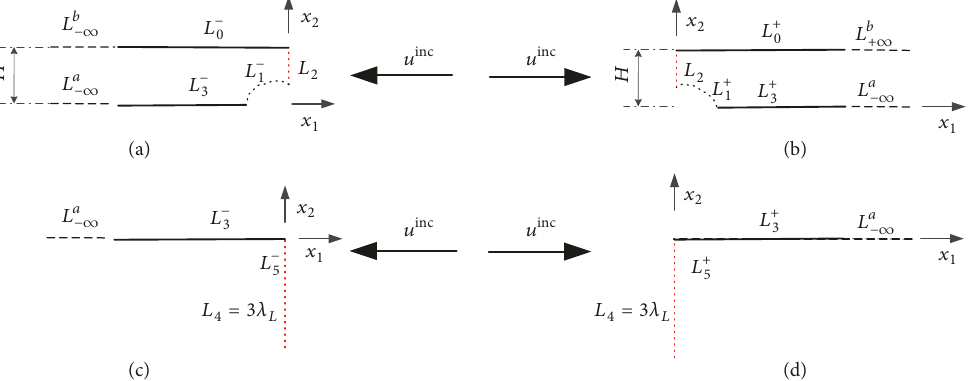
Figure 3: Schematic diagram of the multidomain approach: (a) calculate 𝐴 𝐵− 𝑖 ; (b) calculate 𝐴 𝐵+ 𝑖 ; (c) calculate 𝐴 𝐴− 𝑖 ; (d) calculate 𝐴 𝐴+ 𝑖 .